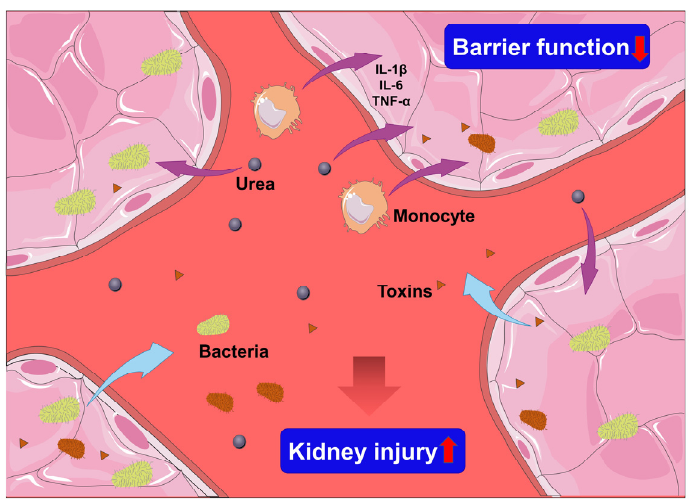
Figure 4. Mechanisms of kidney–gut interactions. During AKI, the accumulation of urea and the infiltration of monocytes cause gut barrier damage, which then allows harmful bacteria and their toxic metabolites (toxins) to leak into the circulation system and leads to further kidney injury. The brown and yellow bateria represent different species of bateria in the gut. The purple arrow indicate the transfer of urea or inflammatory cell form blood into gut. The bule arrow indicate bateria or toxins entering circulation form gut.